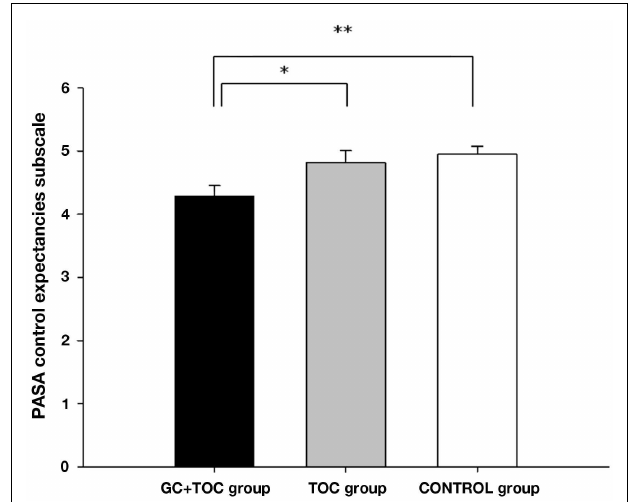
FIGURE 1 | PASA control expectancies subscale before theTSST-C (MEANS ± SEM) in children with glucocorticoid administration and tocolytic (GC + TOC; n = 43), in children of theTOC group ( n = 35), and in children of the CONTROL group ( n = 37) (** p < 0.01, * p < 0.05).